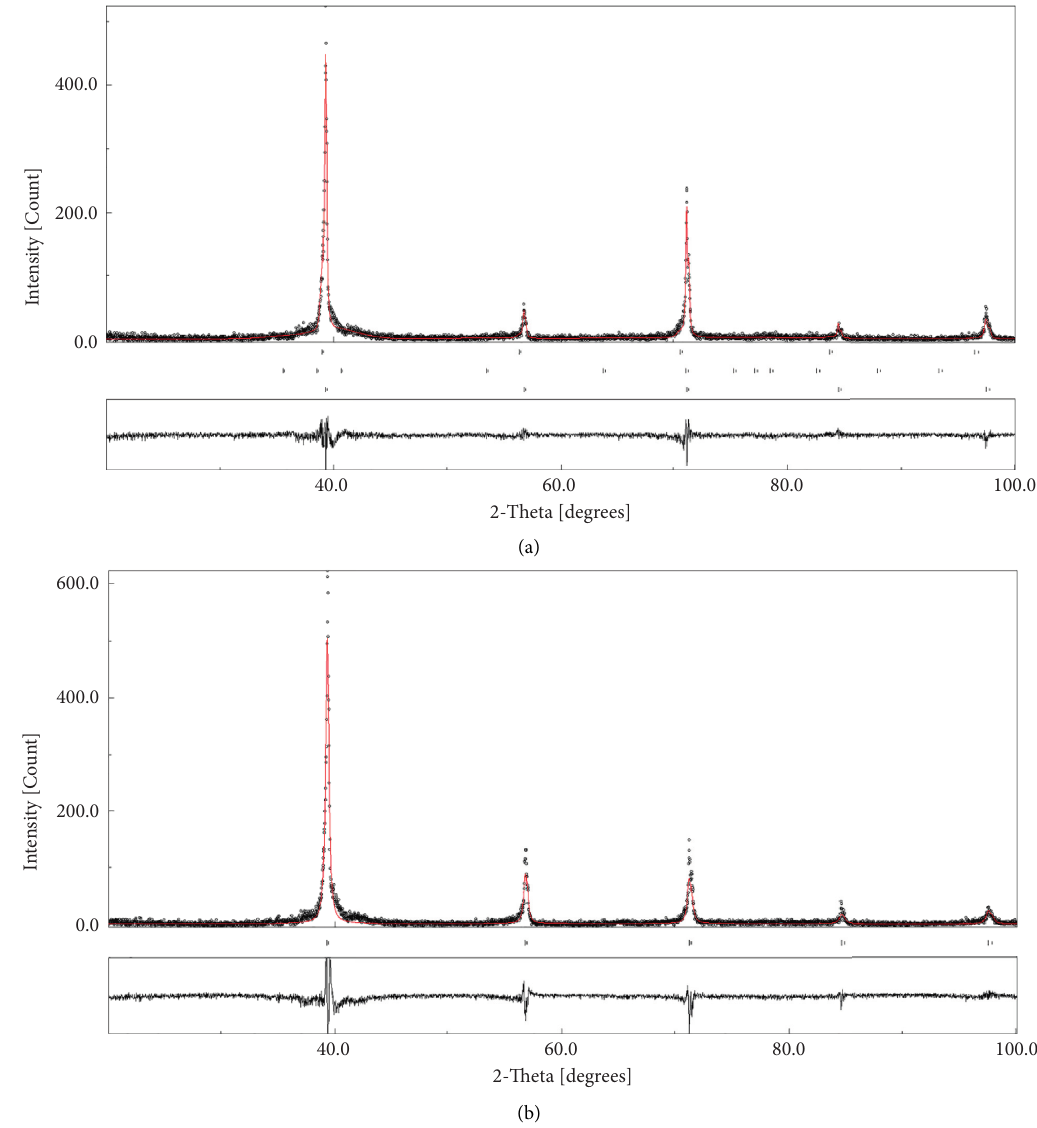
Figure 6: The XRD pattern of (a) samples rapidly heated to 860 o C and (b) samples rapidly heated to 925 o C followed by